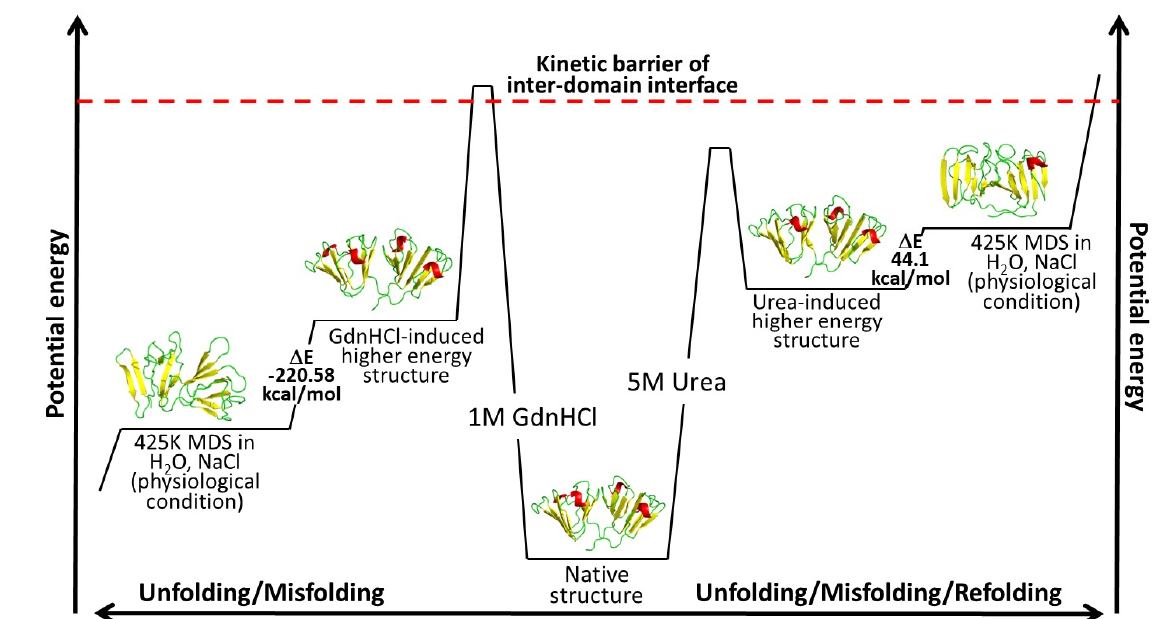
Figure 10. Schematic diagram of the energy model for the HGDC simulated structures with respect to the potential pathways they may